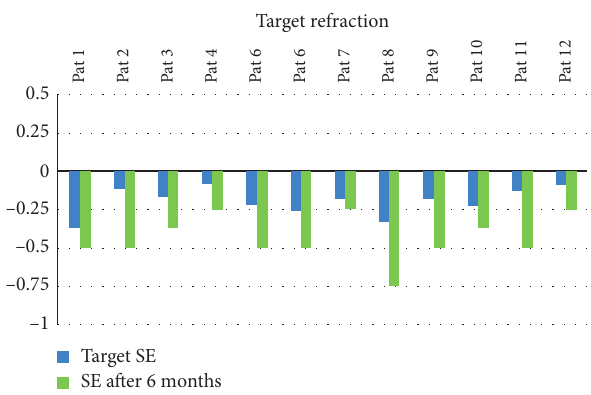
Figure 2: The spherical equivalent (SE) before and after IOL scleral fixation is shown. The difference between the mean preoperative target SE and the mean postoperative SE was not significant ( p � 0 . 87 )